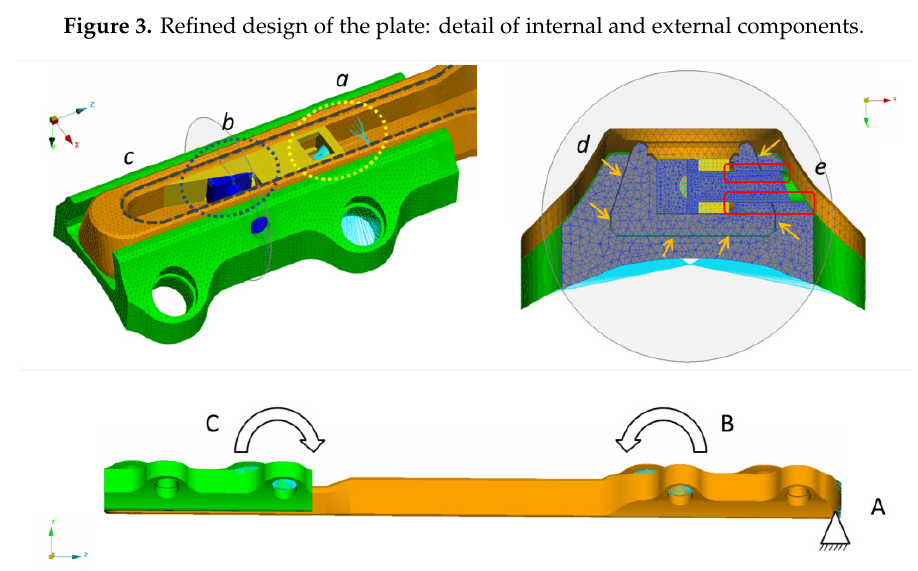
Figure 4. Upper Image—detail of mesh and connections: ( a ) connection between inclined plane and main body; ( b ) connection between the pin and the inclined plane; ( c ) connection between the main body and the cover (not represented in the image); ( d – e ) details of the gap between main body and guide and between the pin and its housing; Lower image—detail of applied loads: (point A ) full lateral constraint (6 DOF: Degrees Of Freedom); (point B – C ) opposite bending moment applied at the master nodes of the two rigid kinematic joints ( RBE2 ).